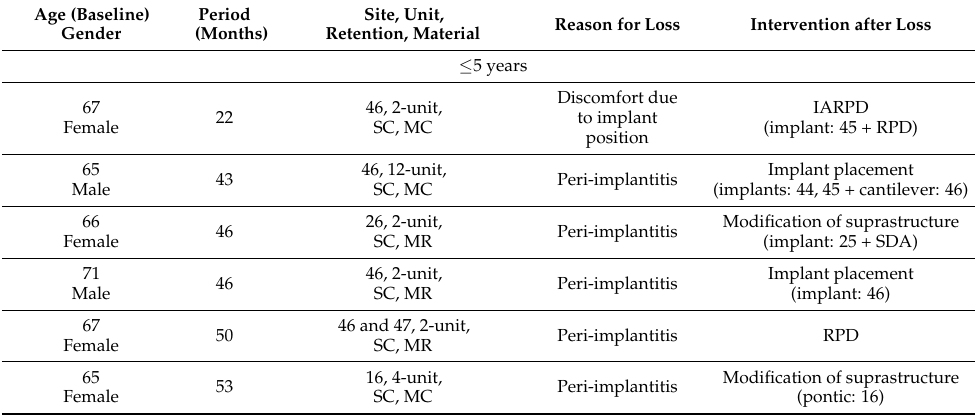
Table 5. Detailed data of the lost